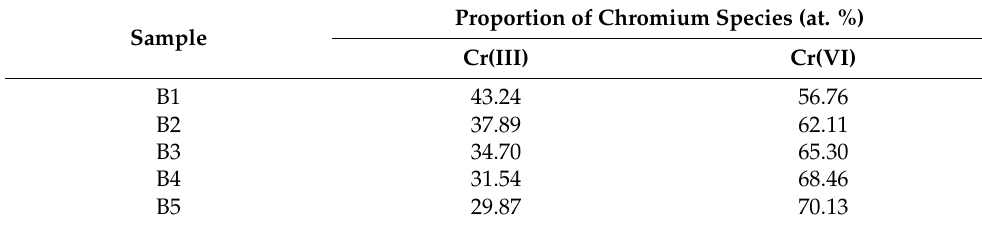
Figure 3. XPS spectra of the synthesized samples B1–B5. Table 3. XPS semiquantitative analysis of cement samples